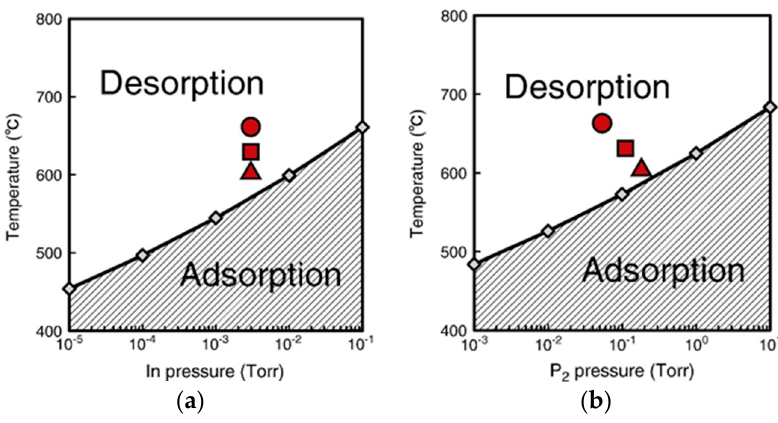
Figure 34. Calculated phase diagrams as functions of temperature and pressure on the In-adsorbed ( 1120 ) surface for adsorption of ( a ) In and ( b ) P atoms. Regions with hatched lines correspond to atom-adsorbed regions. Red circles, squares, and triangles represent the growth conditions for the high temperature and low V/III ratio, the intermediate temperature and V/III ratio, and the low temperature and high V/III ratio, respectively. In pressure is fixed at 3.3 × 10 − 3 Torr which corresponds to the experimental growth conditions [90,91]. Reprinted with permission from [99]. Copyright (2013) by Elsevier.